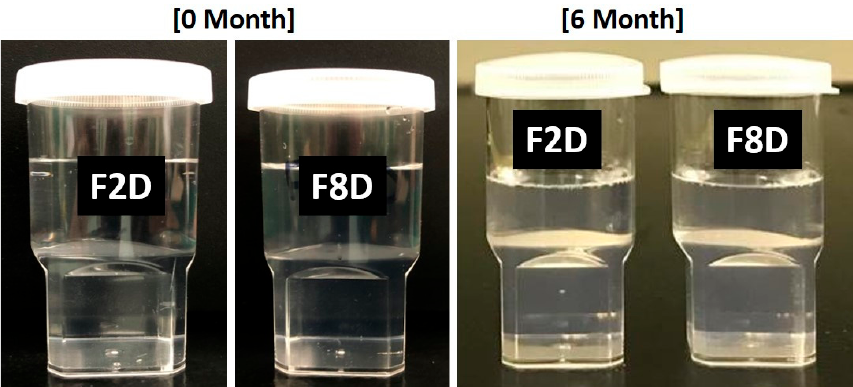
Figure 8. Appearances of the propofol-loaded F2 (PF2-SNEDDS) and F8 (PF8-SNEDDS) lipid-based formulations after six months of storage conditions at 37 °C. The formulations were diluted with water. “D denotes drug-loaded”. The left images represent at 0 months and the right images at 6 months.